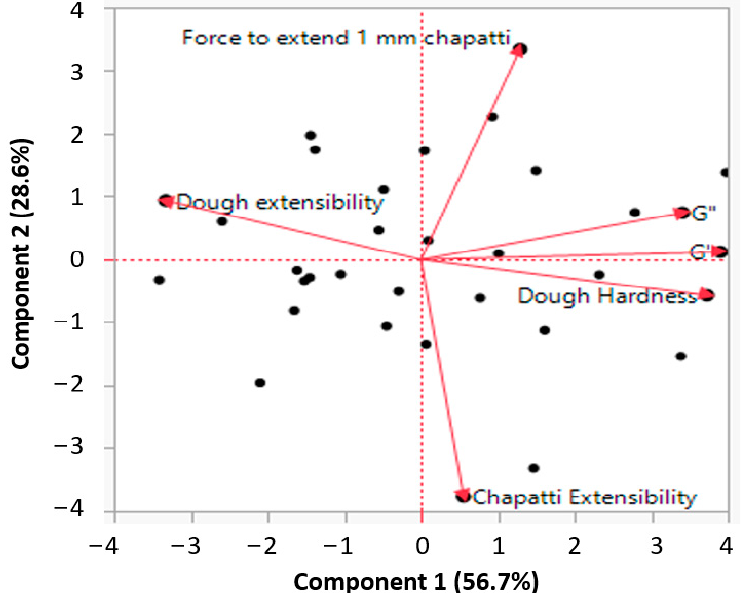
Figure 1. PCA biplot representing the rheological and textural properties of wheat-cricket flour dough and baked chapatti as affected by different hydrocolloids and water content.